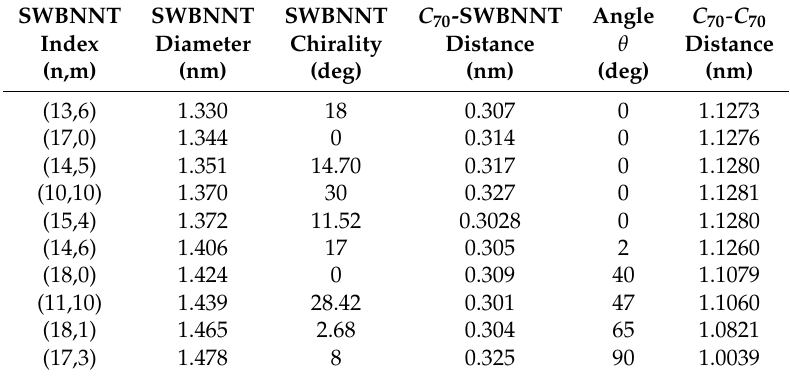
Table 2. Optimized structural parameters of the C 70 molecules inside BNNT in diameter range where the C 70 molecules adopt a linear chain inside nanotubes.